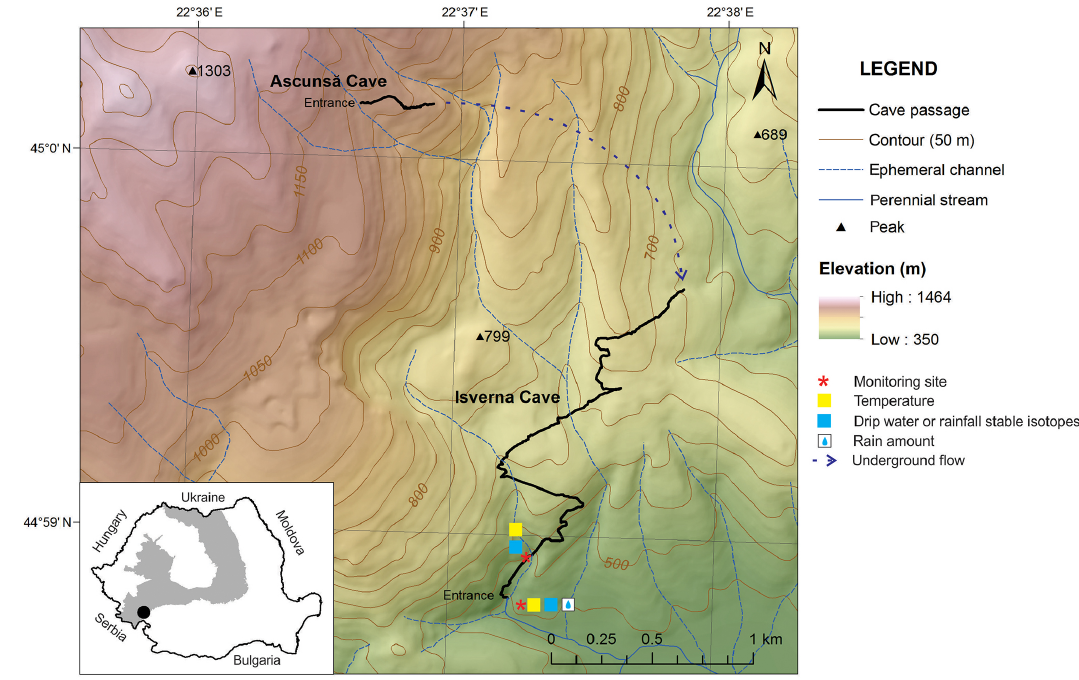
Figure 1. Location of Ascuns˘a and Isverna caves within the region.